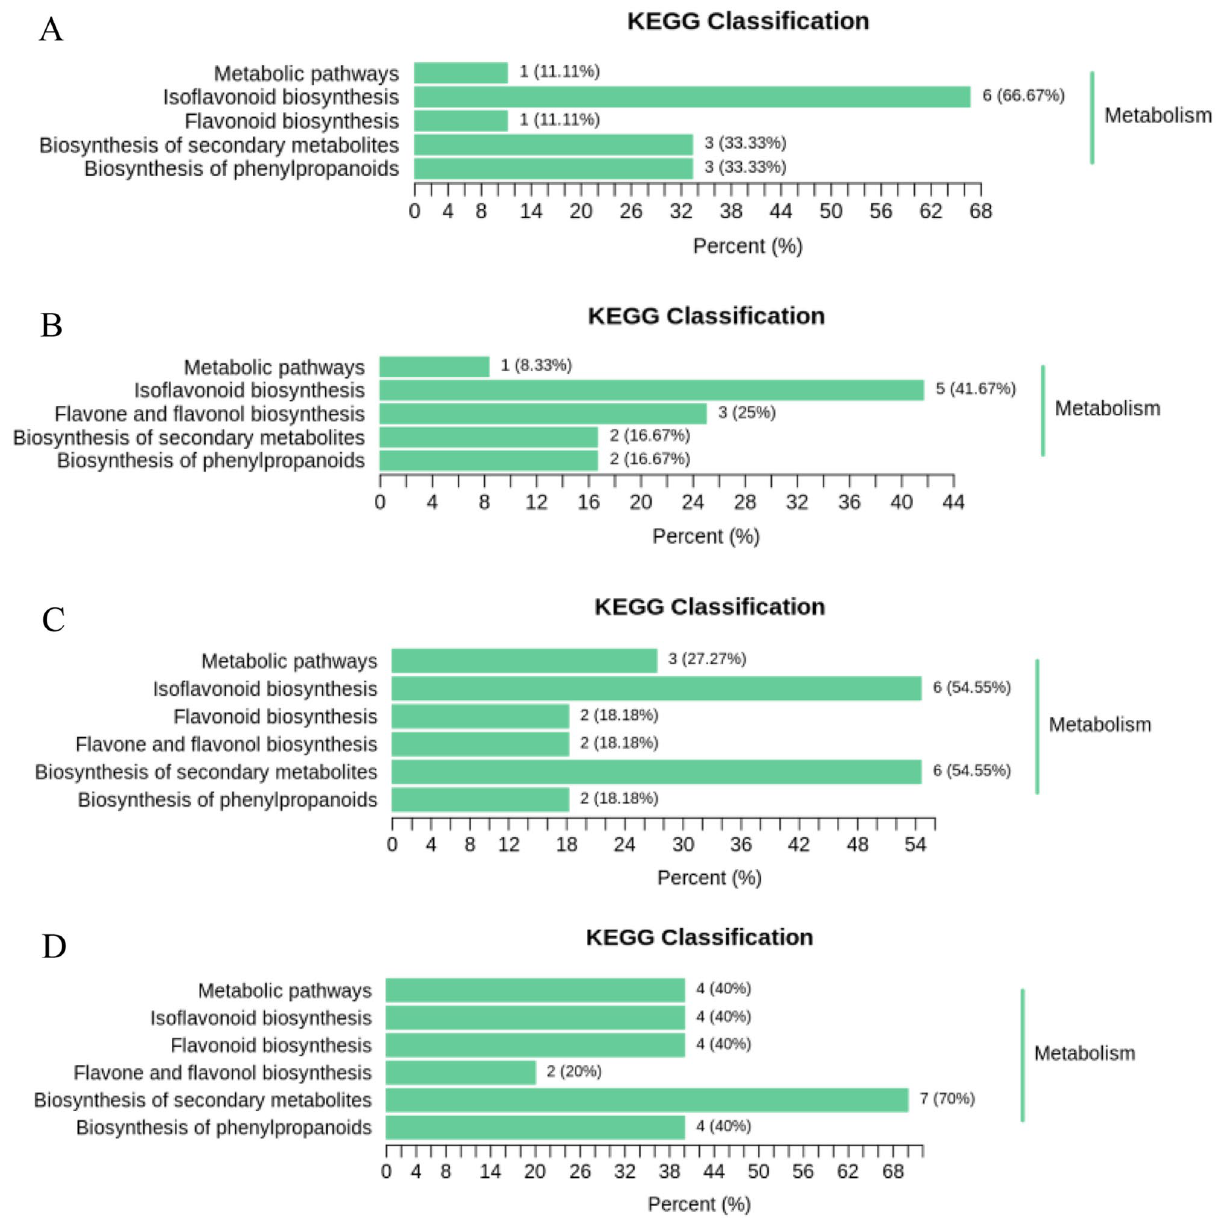
Figure 6. Differential metabolite KEGG classification chart. ( A ): HN52 vs HN71; ( B ): HNS52 vs HNS71; ( C ): HN52 vs HNS52; ( D ): HN71 vs HNS71. Note: The ordinate is the name of the KEGG metabolic pathway, and the abscissa is the number of metabolites annotated to the pathway and its proportion to the total number of metabolites